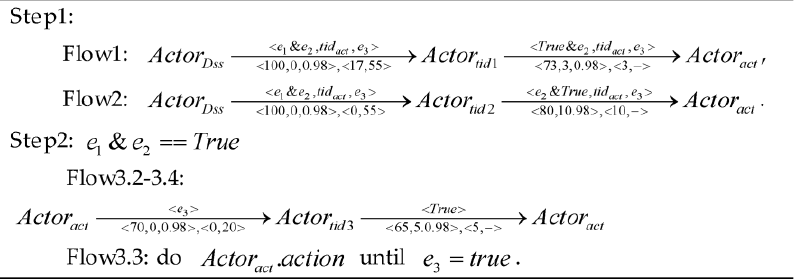
Figure A2. The detail process flow for Figure A1.